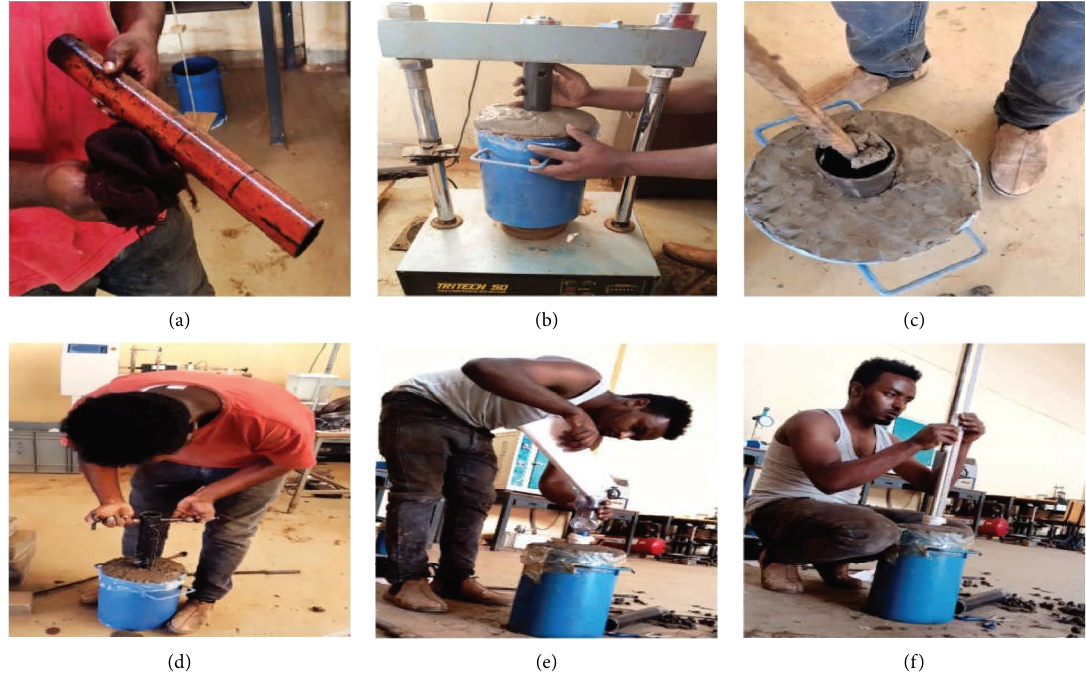
Figure 7: (a) Greasing open-ended pipe, (b) inserting open-ended pipe into clay bed, (c) scooping out soil in the pipe, (d) twisting pipe to withdraw, (e) pouring cinder gravel to the prepared hole for cinder gravel column, and (f) compaction of cinder gravel column in to